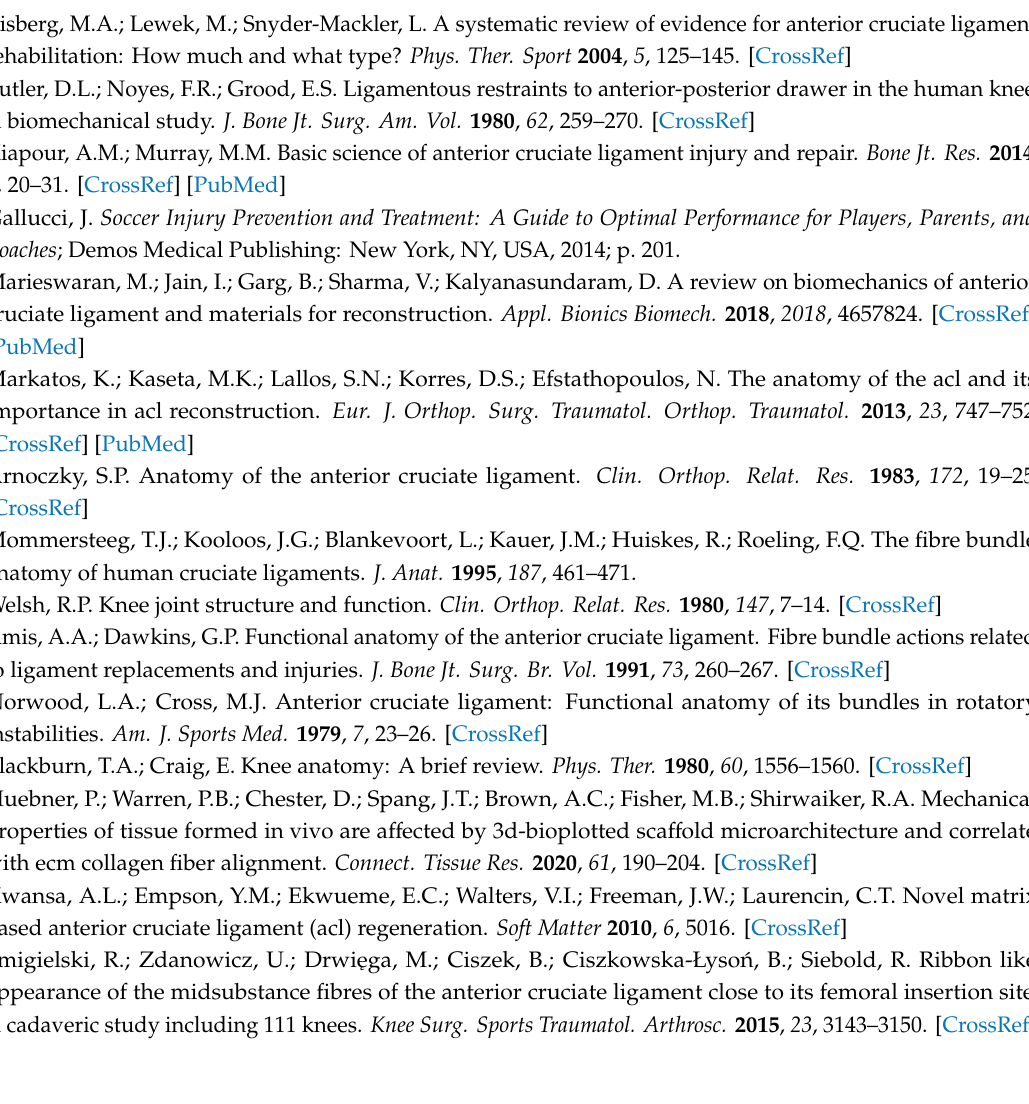
Table S1: Significance values of apparent modulus, 5% strain, and 20% strain for flexible specimens having a raster angle of 0 ◦ , Table S2: Results of one-way ANOVA Tukey’s multiple comparison test comparing the mechanical properties of flexible specimens with a raster angle of 45 ◦ , Table S3: Results of one-way ANOVA Tukey’s multiple comparison test comparing the mechanical properties of flexible specimens with a raster angle of 90 ◦